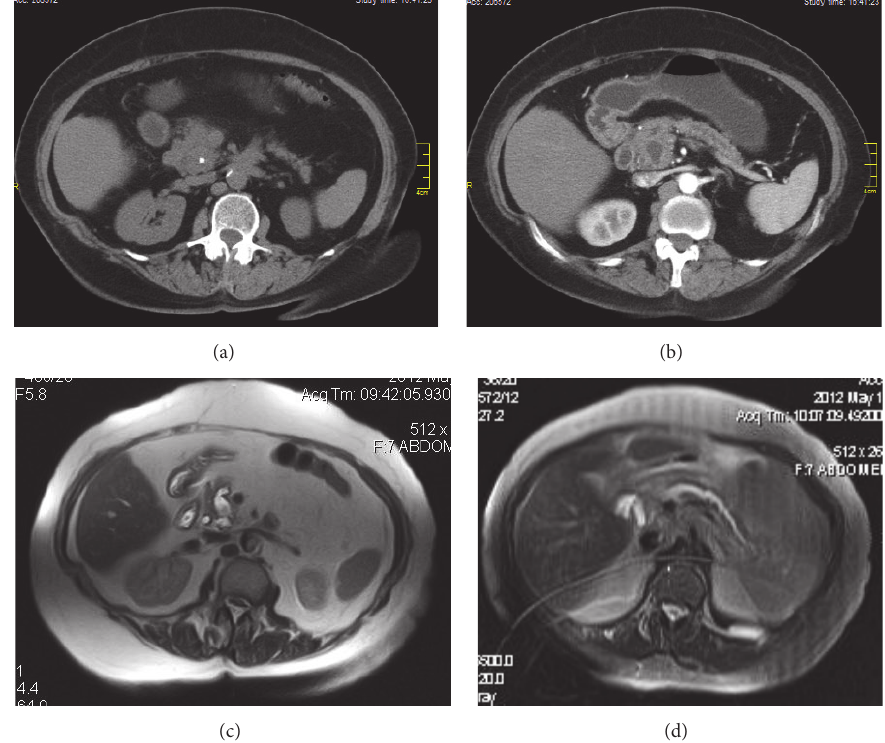
Figure 1: CAT scan ((a) and (b)) and magnetic resonance ((c) and (d)) images before the surgery. (a) Pancreatic head increased in size, with focal calcification, without mass lesion. (b) Dilated pancreatic duct in the whole pancreas, with major diameter, and fusiform dilatation in the pancreatic head. Slight atrophy of pancreatic parenchyma. (c) Fusiform dilated main pancreatic duct in the pancreatic head, with small filling defect suspected. (d) Dilated main pancreatic duct in pancreatic body and tail, with slight atrophy of